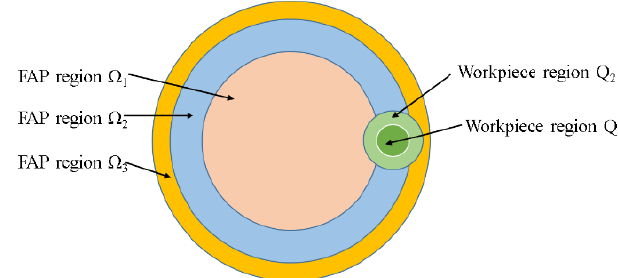
Figure 6. Schematic diagram of the ring damping